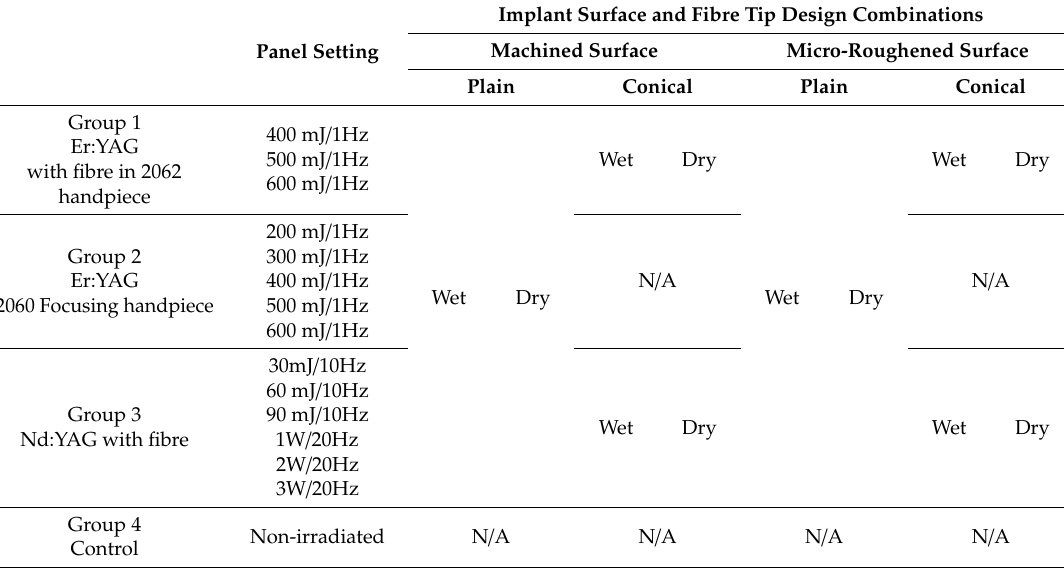
Table 1. Experimental design.